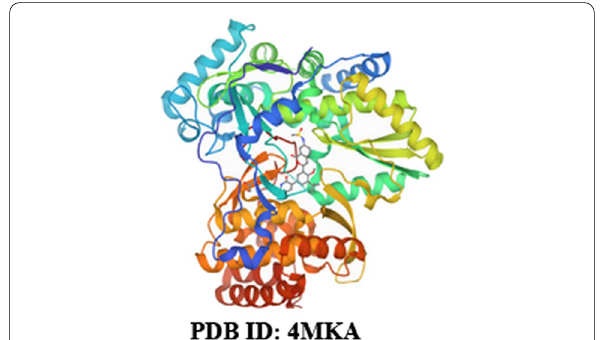
Fig. 1 Structure of the target receptor (hepatitis C virus NS5B RNA polymerase) in complex with dasabuvir